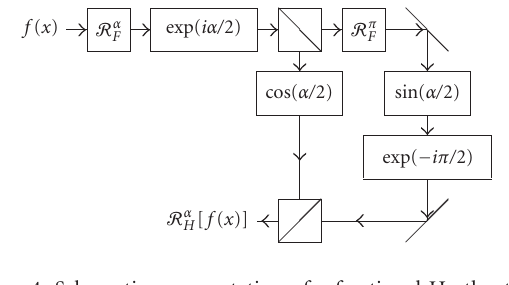
Figure 4: Schematic representation of a fractional Hartley trans- former. The setup consists of two fractional FTs R α beam splitters, two mirrors, two absorbing plates cos( α/ 2) and sin( α/ 2), and two phase plates exp( iα/ 2) and exp( − iπ/ 2).